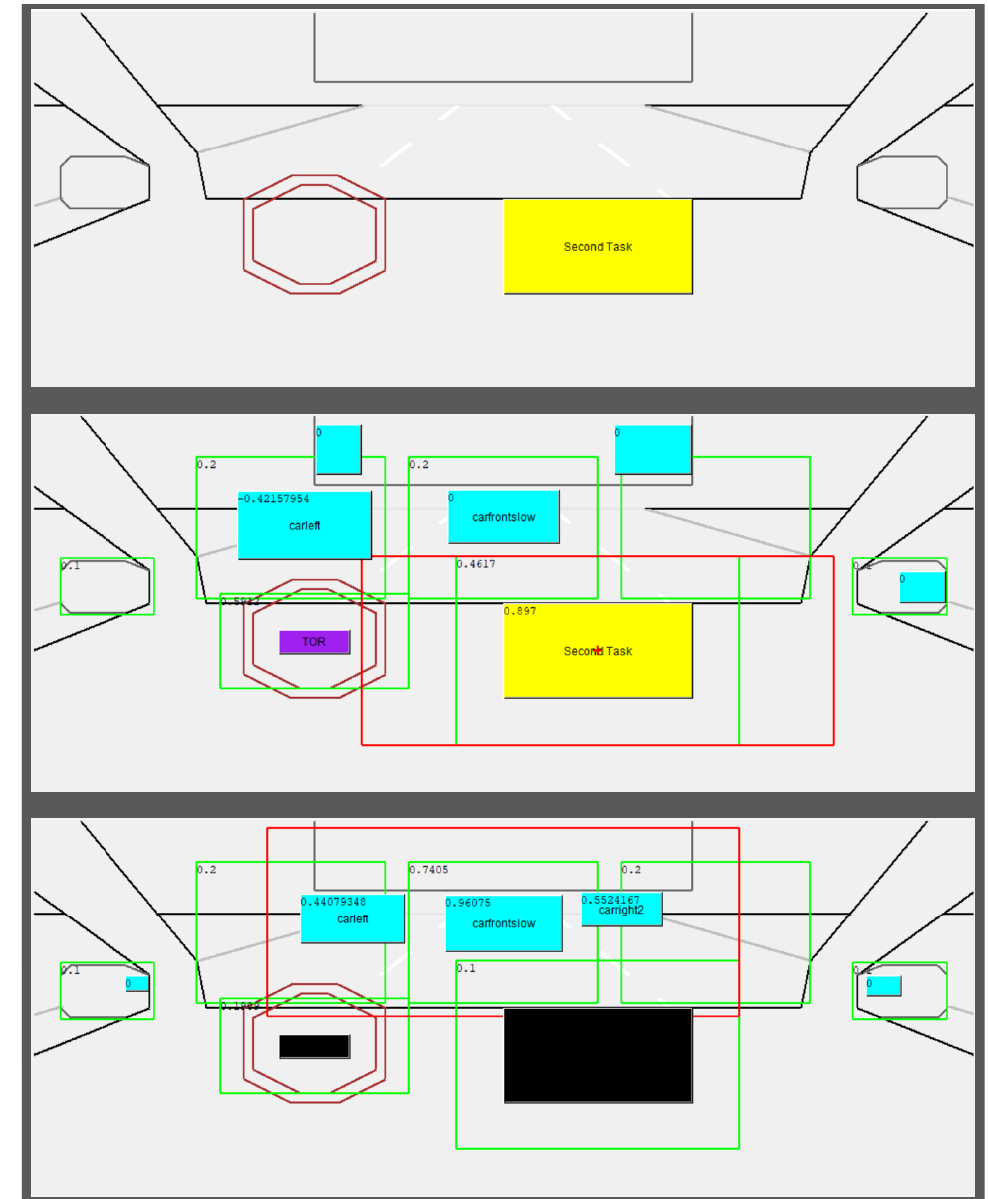
Figure 1. Original screenshot of the graphical user interface that the cognitive model interacts with. The screenshot represents the areas of interest (green frames), the field of view (red frames), and vehicles in the traffic environment (solid blue/green squares). Depicted example scenes show from top: the lane graphics and the NDRT, a complex traffic scenario with TOR (takeover request; violet solid square), and NDRT active (yellow solid square), traffic scenario with NDRT and TOR deactivated (black solid squares; source: own